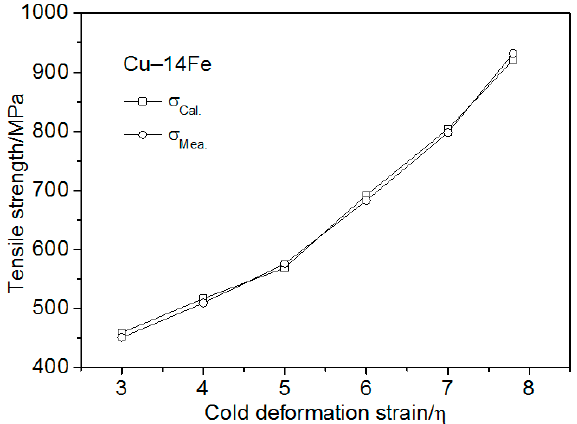
Figure 11. Cu–14Fe strength as-measured and calculated using the combinatorial strengthening model vs. strain.